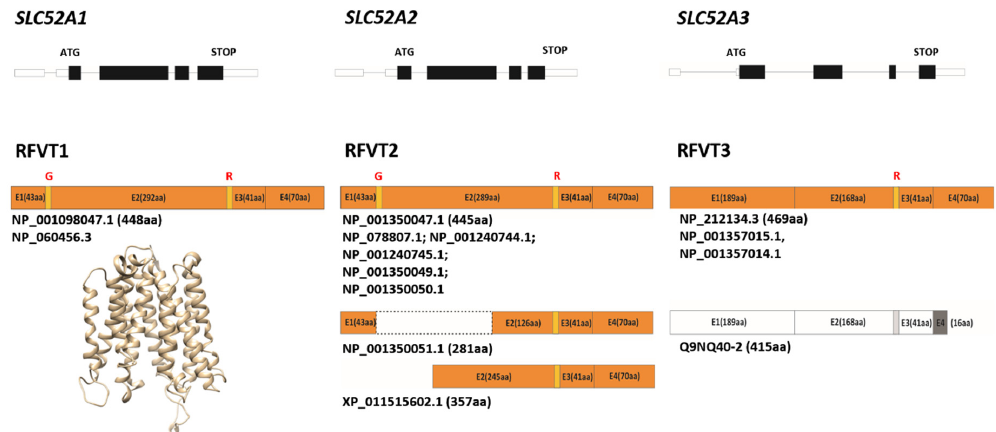
Figure 2. Sketch representation of RFVT protein isoforms. At the top of the figure, schematic representation of genes encoding for RFVT1, RFVT2 and RFVT3. Exons are represented as black boxes, introns as lines between exons and UTRs as short white boxes. In the lower part of the figure, schematic representation of RFVT protein isoforms. In orange RFVT isoforms as reported in NCBI; in white a RFVT3 isoform, as reported in [43]. Length as coded amino acids for each exon is reported (in brackets). Under each isoform, accession number and length for each protein. The homology structural model of hRFVT1 was built, using as a template the equilibrative nucleoside transporter 1 (PDB code 6OB7) using the SWISS-MODEL software. The protein shows the 11 transmembrane α -helical segments nearly parallel to the membrane axis.